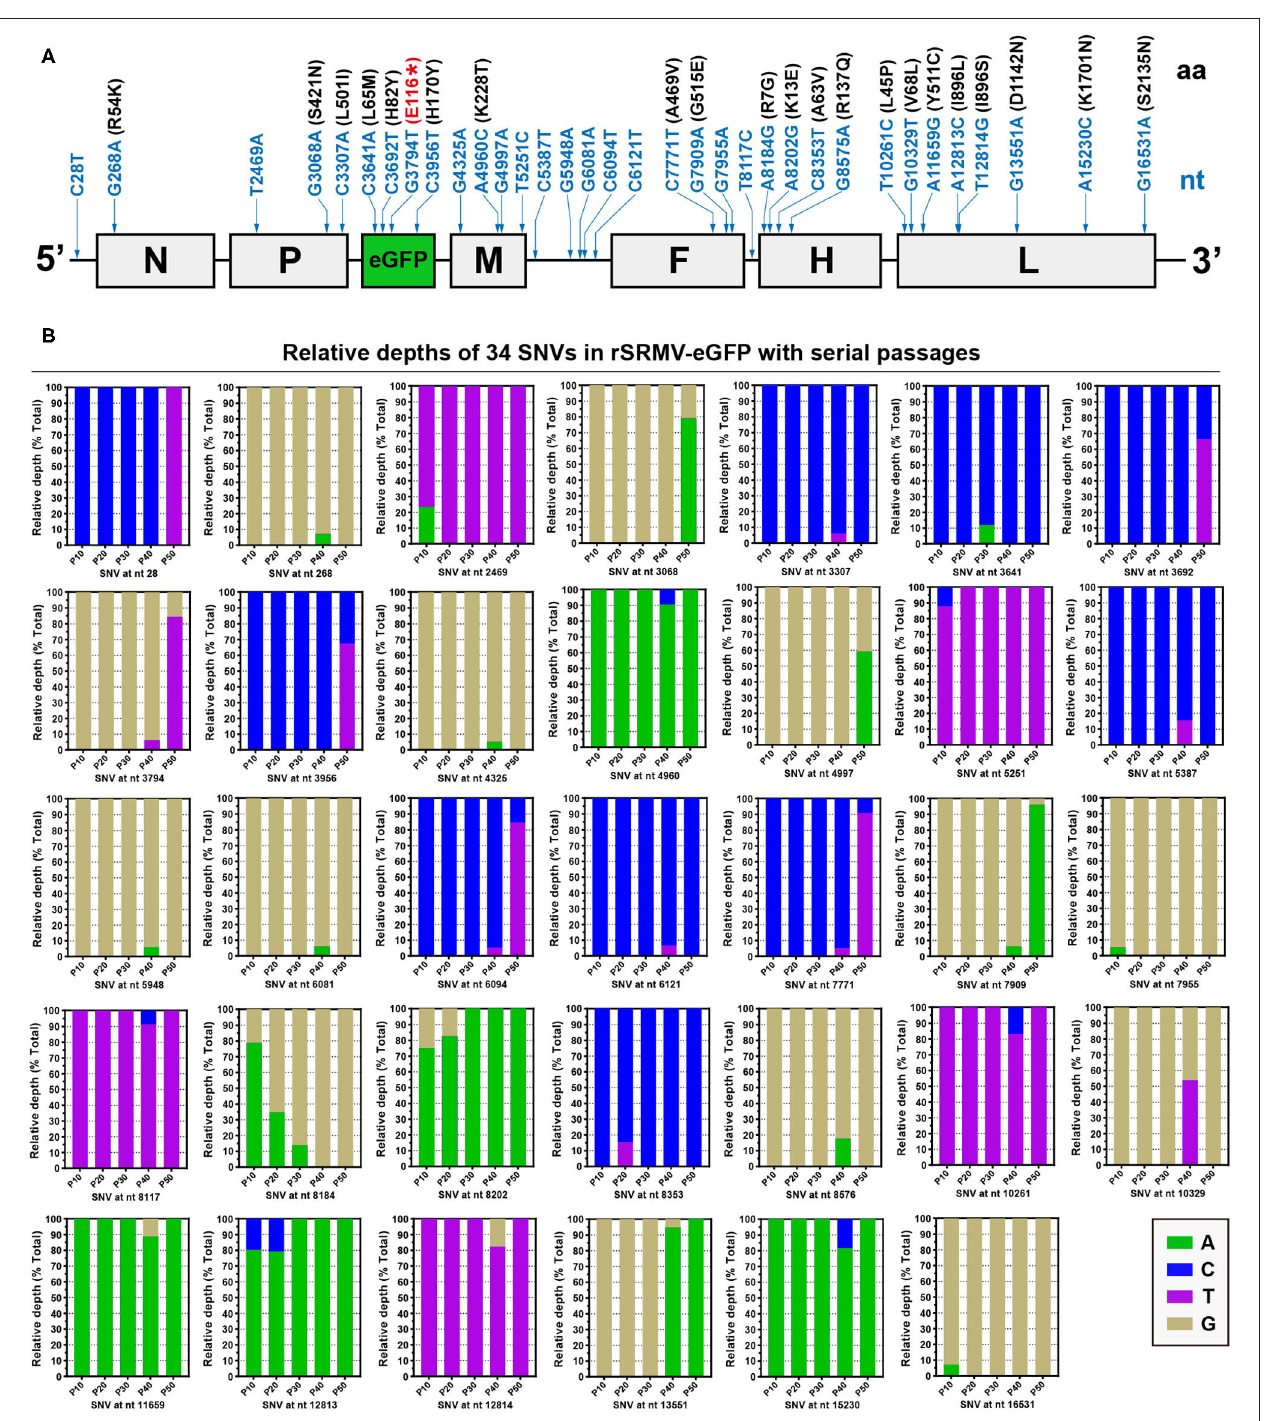
FIGURE 3 | Progeny profiles of nucleotide and amino acid mutations at P10, P20, P30, P40, and P50. All detectable single-nucleotide and -amino acid mutations in rSRMV-eGFP antigenome during passaging (A) . The positions of SNVs are independently indicated with blue arrows. SNVs are marked with blue letters and numbers. Missense mutation-caused amino acid substitutions are marked with black letters and numbers in black brackets. The non-sense mutation, G3794T, causes early termination of eGFP translation, marked with “(E116*)” in red. All elements do not match their actual lengths in proportion. Relative depths of next-generation sequencing for 34 SNVs in rSRMV-eGFP antigenome with 45 serial passages (B) . The relative depth is referred to as the proportion of sequencing depth of a given nucleotide to the total.